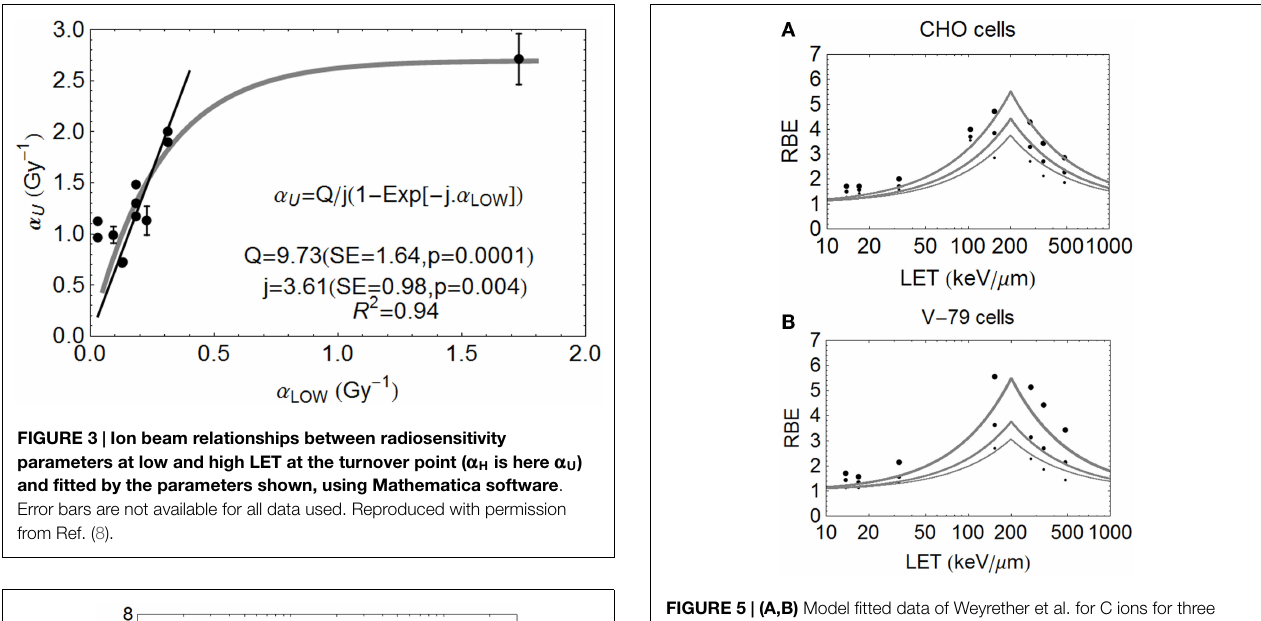
FIGURE 5 | (A,B) Model fitted data of Weyrether et al. for C ions for three different cell lines and doses, coded in the same way as for Figure 4 with respect to line thickness and surviving fraction (A) for CHO cells and (B) for V-79 cells.